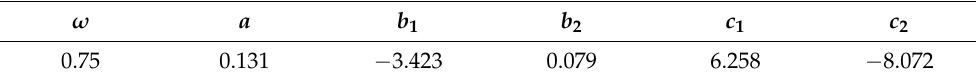
Table 1. Numerical constants used in Equation (7) (values from